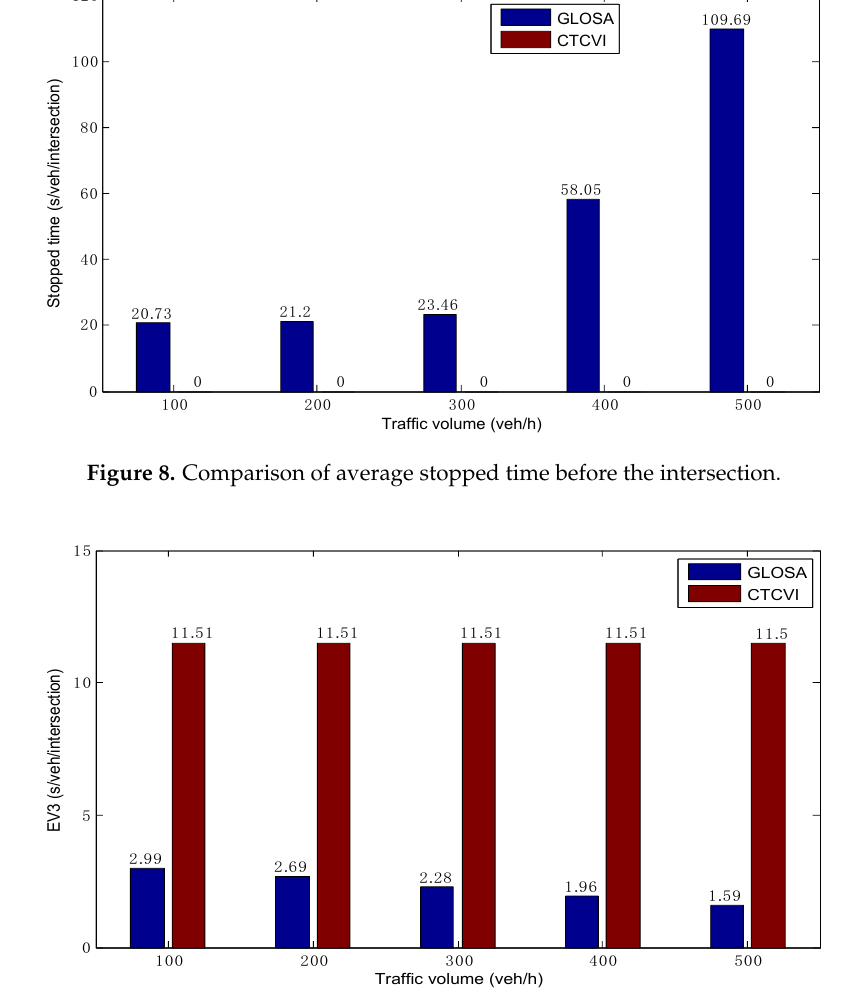
Figure 9. Average travel speed for entering the intersection.